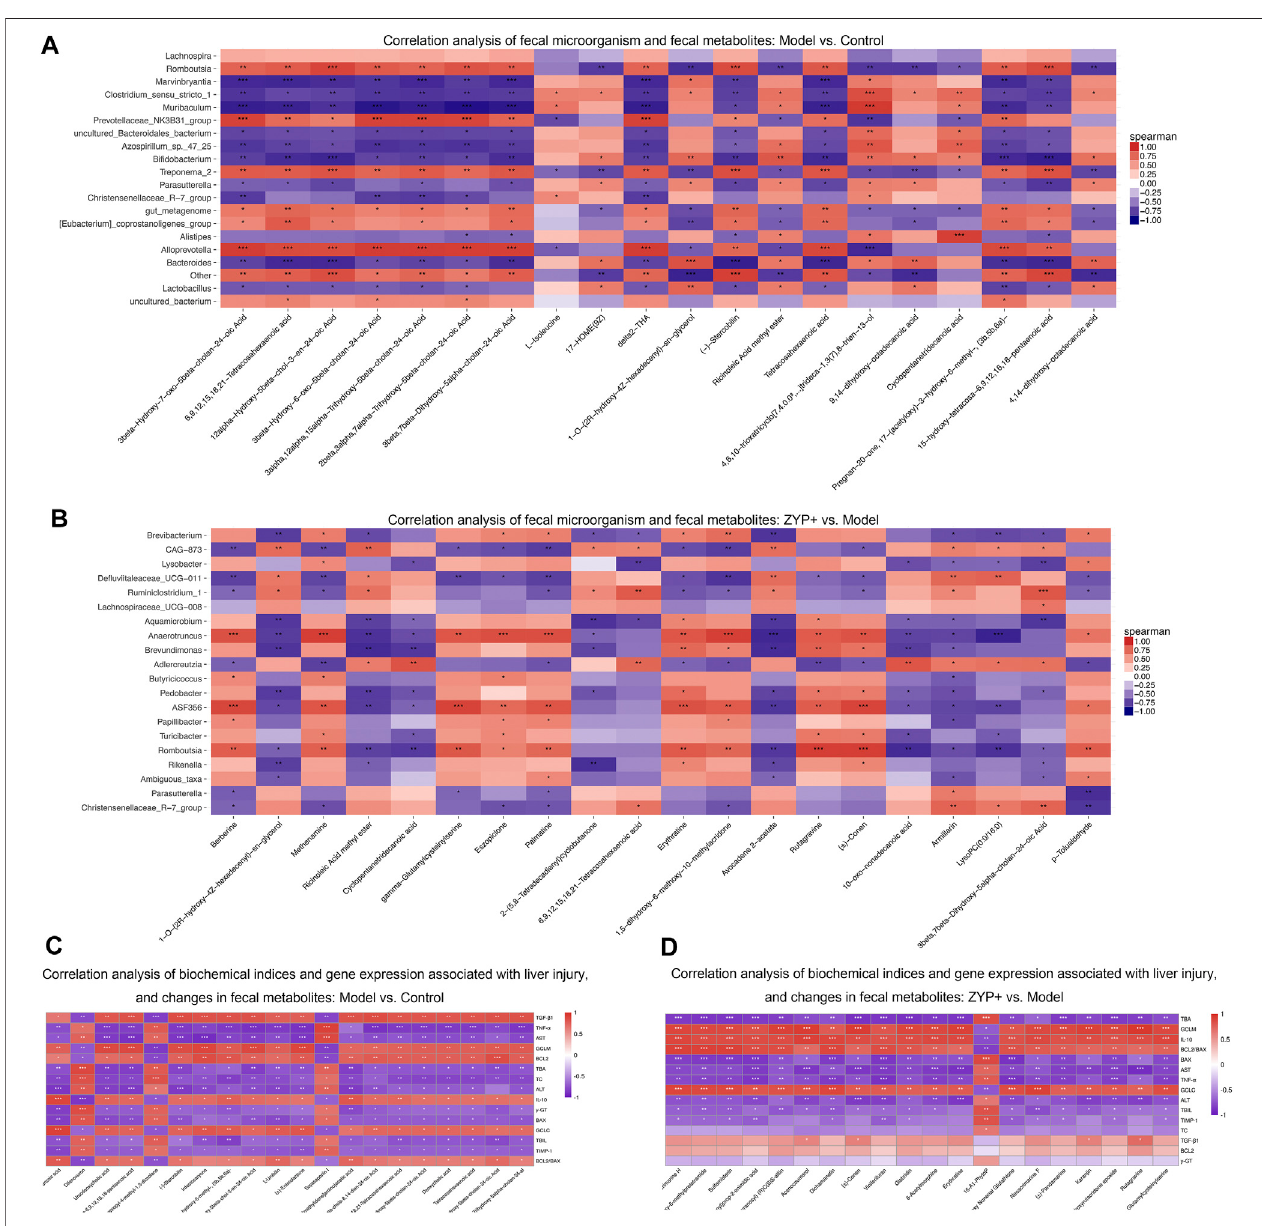
FIGURE 8 | Combined analysis of blood biochemistry, gene expression changes, fecal microorganism composition, and fecal metabolism variables in liver injury. Correlation analysis of fecal microorganism and fecal metabolites (A) Cholestasis model vs Control; (B) ZYP+ vs Untreated Cholestasis model. Correlation analysis of biochemical indices and gene expression associated with liver injury, and changes in fecal metabolites (C) Cholestasis model vs Control; (D) ZYP+ vs Untreated Cholestasismodel. * p < 0.05, ** p < 0.01, *** p < 0.001. Thecorrelationmatriceswereobtained fromthe cloud platform ofShanghai OEBiotech, Inc.(https://cloud.